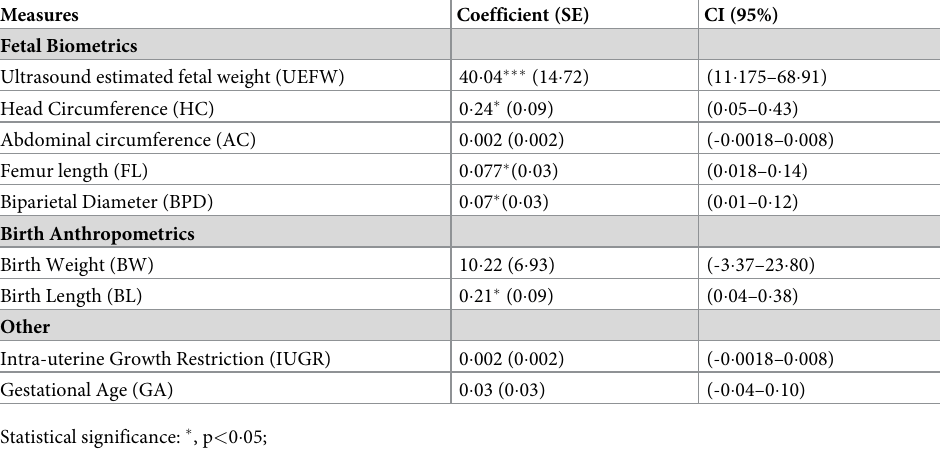
Table 2. Univariate mixed-effects linear regression analysis showing association of PMPD with various measures.